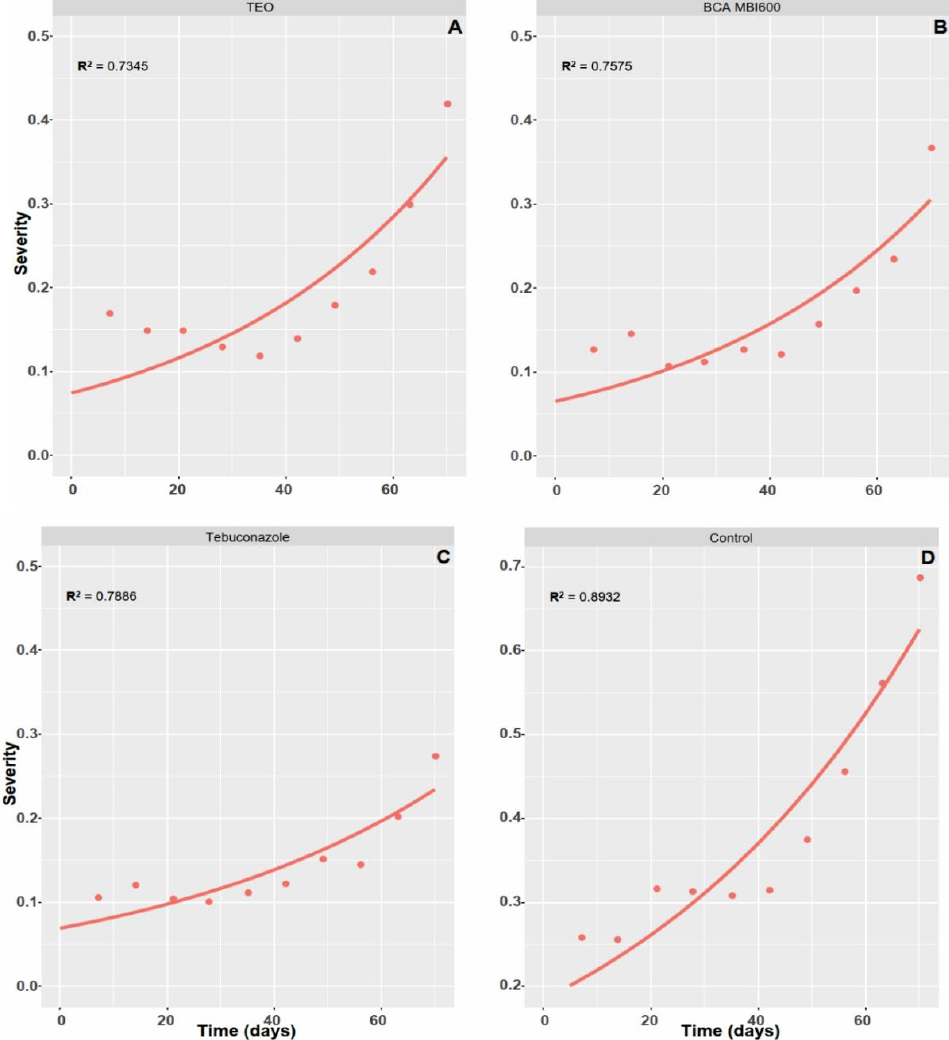
Figure 5. Exponential model fitted curves (lines) to disease progress of tomato early blight under different treatments: ( A ) thyme essential oil (TEO), ( B ) Bacillus amyloliquefaciens MBI600 (BCA MBI600), ( C ) tebuconazole, and ( D ) control (distilled water). Values (points) represent the mean ( n = 12) of the disease index evaluated weekly. R 2 , coefficient of determination.